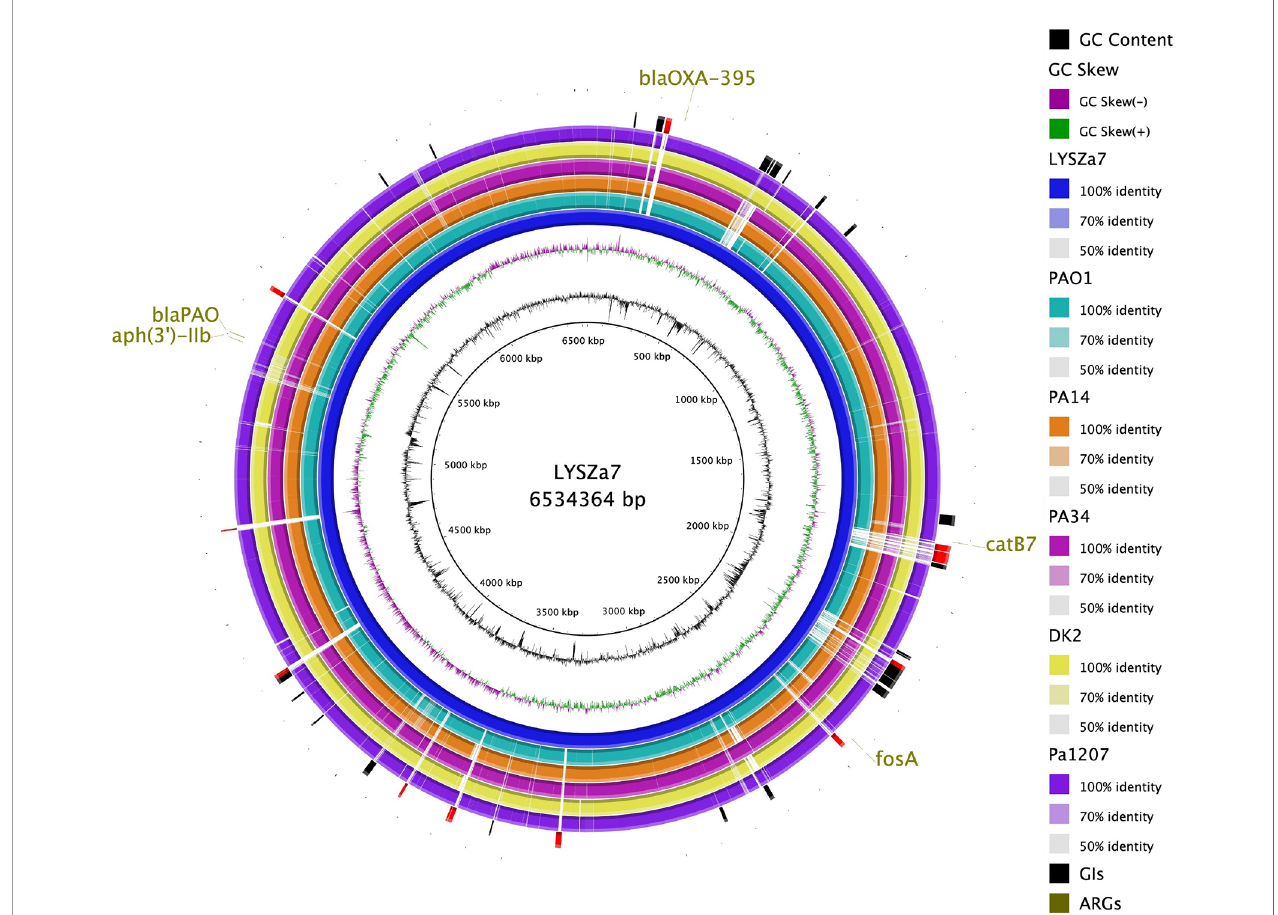
FIGURE 4 | Circular plot. From the innermost, Circle 1: GC content; Circle 2: GC Skew; Circle 3: P. aeruginosa LYSZa7; Circle 4: P. aeruginosa PAO1; Circle 5: P. aeruginosa PA14 (virulent clinical isolate); Circle 6: P. aeruginosa PA34 (strain isolated from Keratitis patient); Circle 7: P. aeruginosa DK2 (Strain isolated from Cystic Fibrosis patient); Circle 8: P. aeruginosa Pa1207 (strain isolated from Bacteremia patient); Circle 9: Genomic Islands predicted with speci fi c GIs of LYSZa7 highlighted in red; Circle 10: Antimicrobial resistance genes (ARGs).